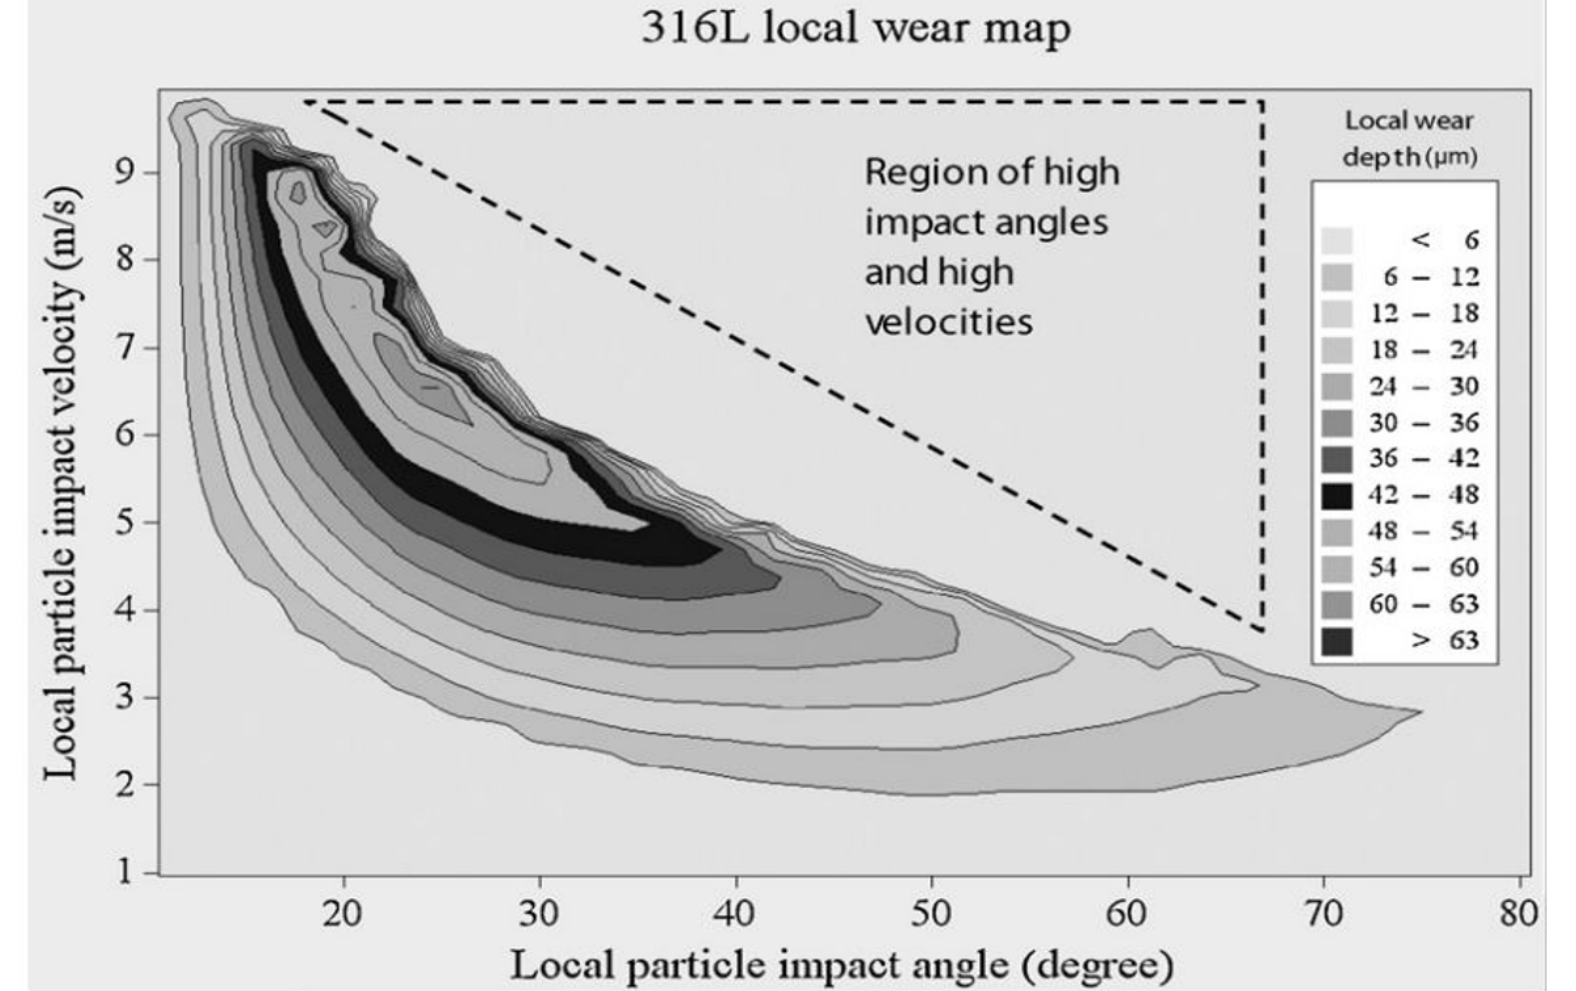
Figure 3. Wear data explained through the material-specific wear map for a duration of 120 min and for a variable jet velocity